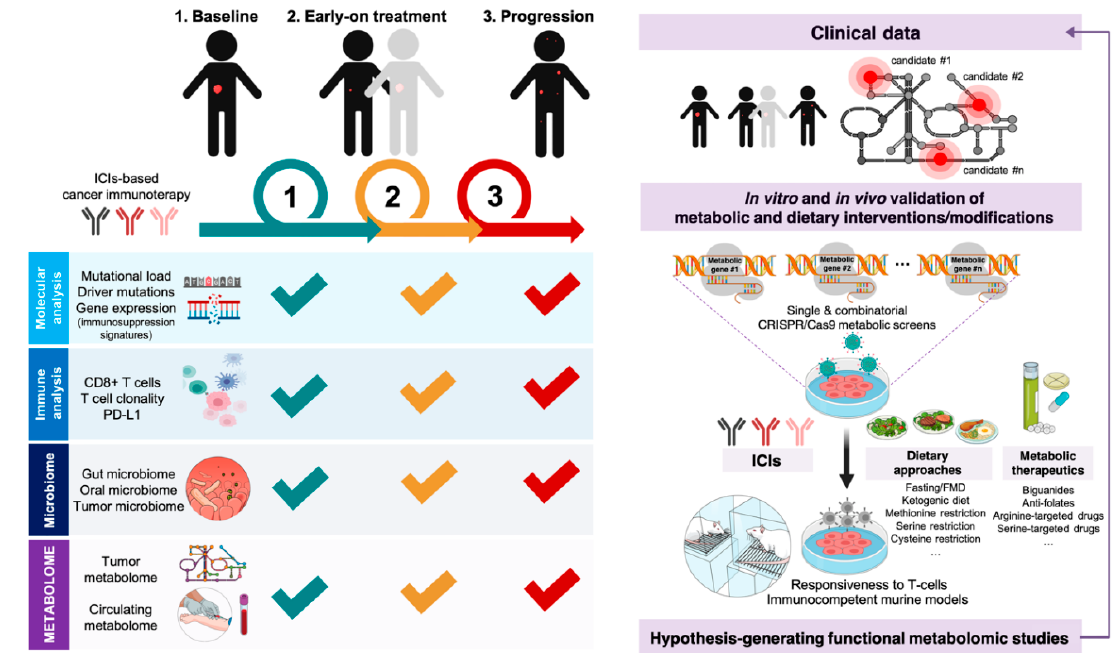
Figure 7. Monitoring metabolic mechanisms of resistance to immune checkpoint blockade